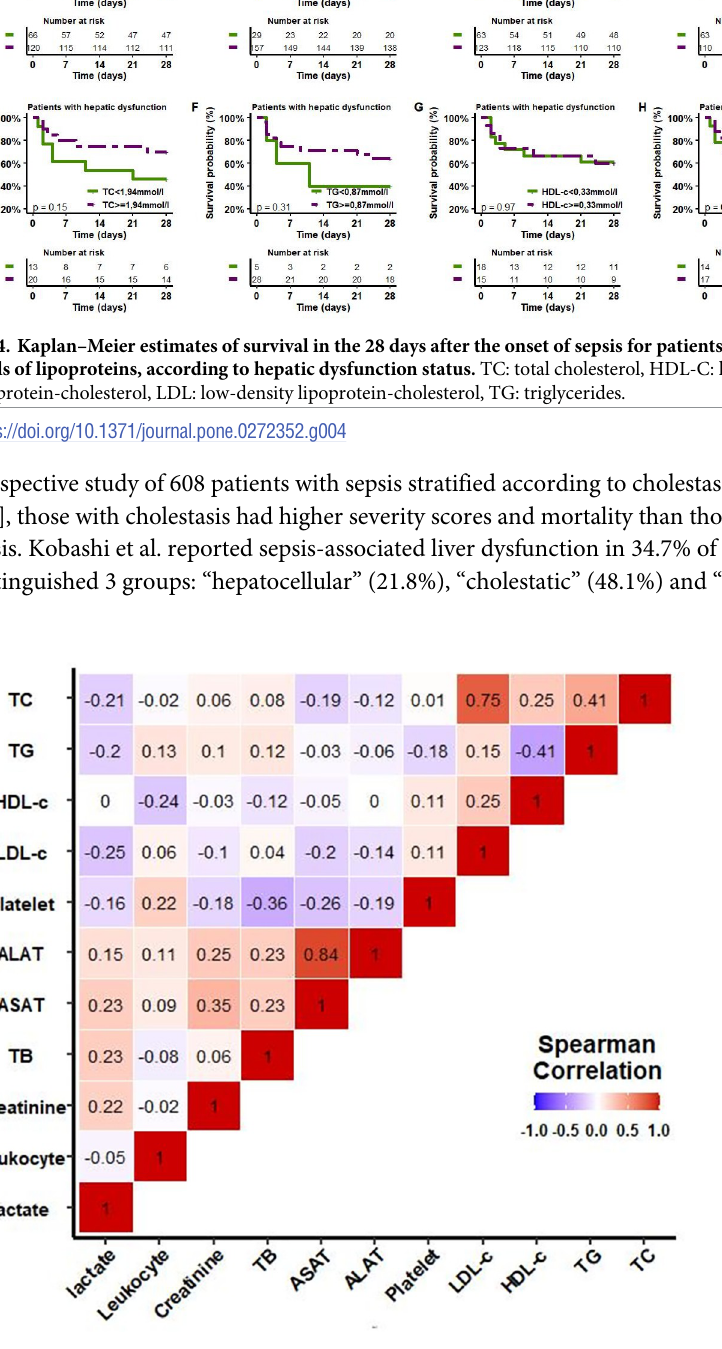
Fig 5. Correlation between lipoprotein, triglycerides, total cholesterol and hepatic markers. TC: total cholesterol, HDL-C: high-density lipoprotein-cholesterol, LDL: low-density lipoprotein-cholesterol, TG: triglycerides, TB: total bilirubin, ASAT: aspartate aminotransferase, ALAT: alanine aminotransferase.